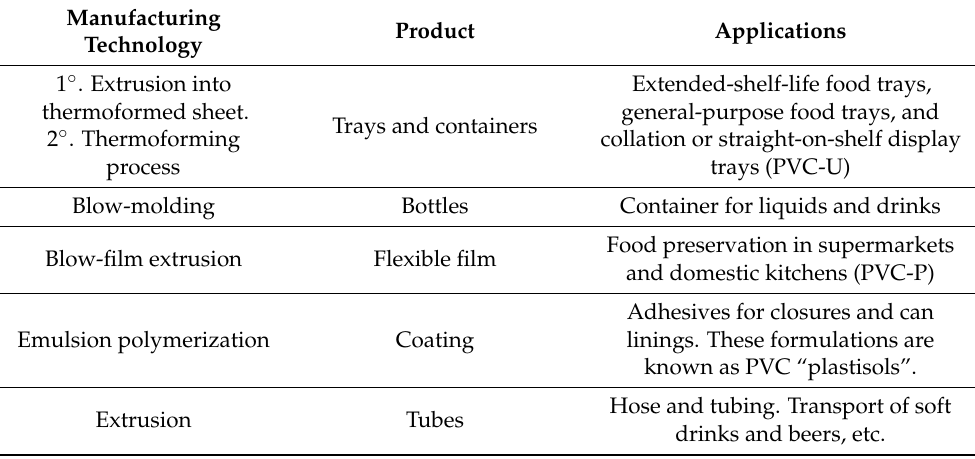
Table 8. Application for PVC-based products